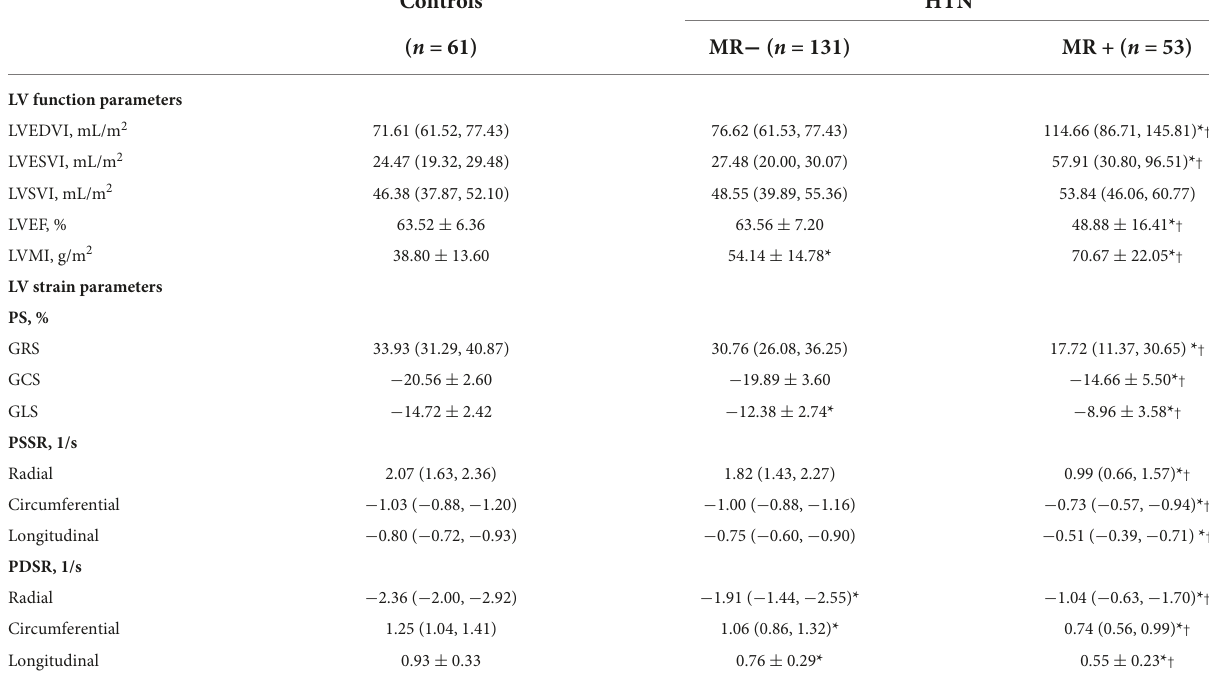
TABLE 2 Comparison of cardiac magnetic resonance findings among hypertensive and control